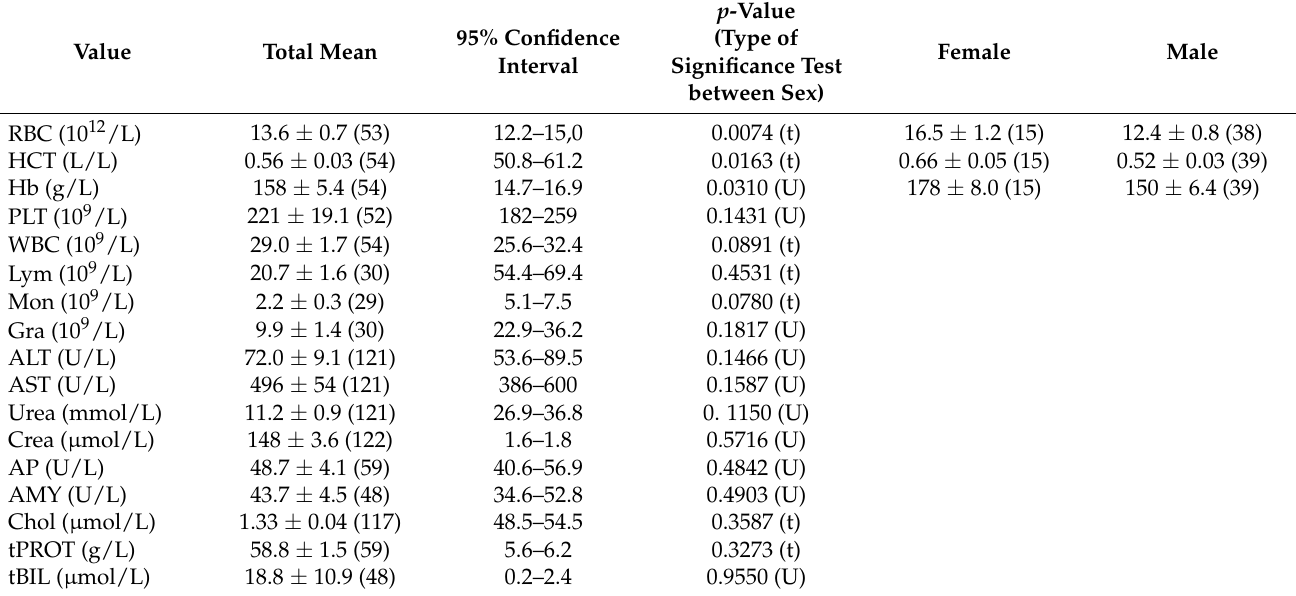
Table 1. Average values (the mean ± standard error (n)) of the morphological and biochemical indicators of roe deer